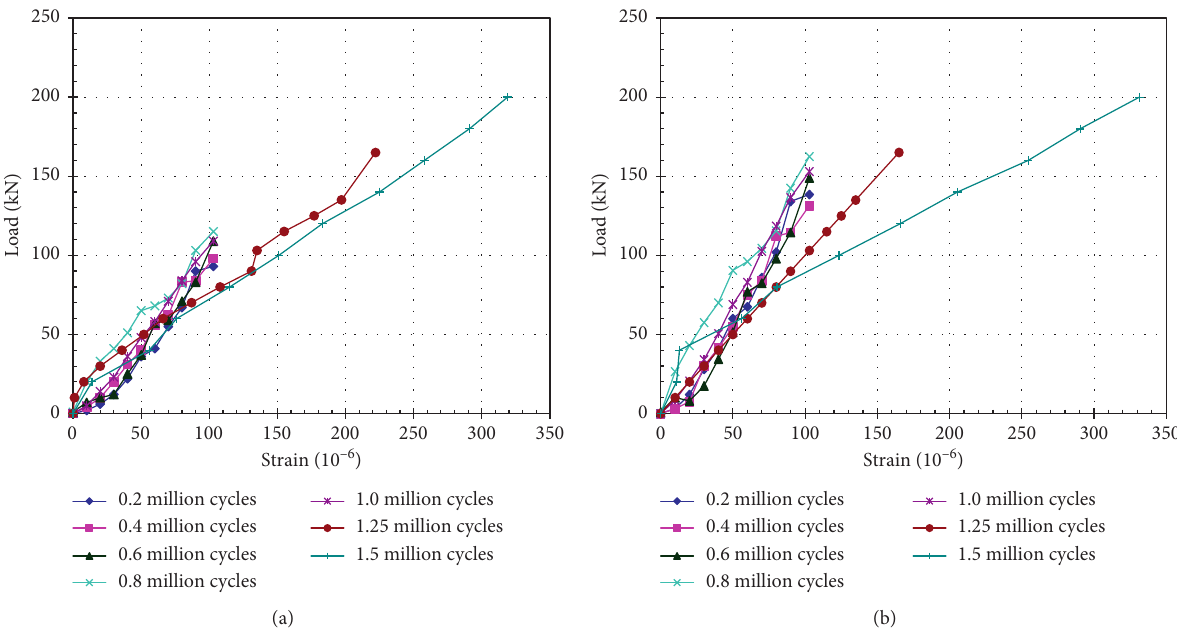
Figure 30: Curve of strain of PLG-2 steel beam with load. (a) Center line section. (b) 0.5 times the beam height section.